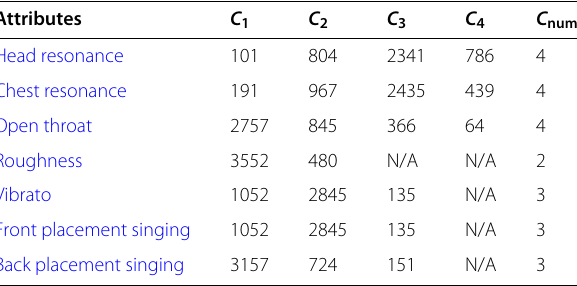
Table 1 Number of vocal segments in each class of each paralinguistic singing attribute in